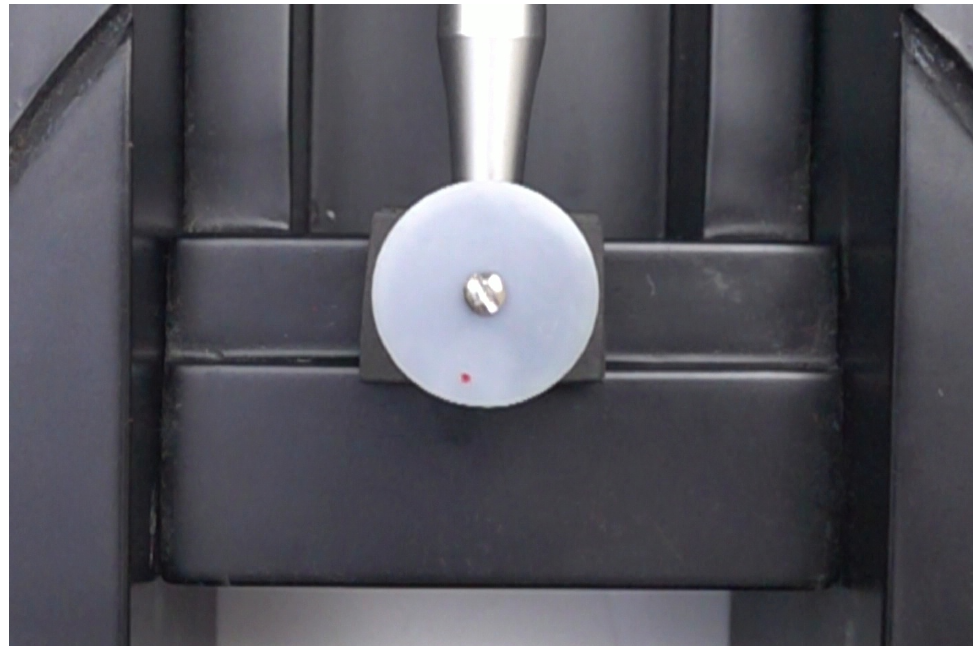
Figure 2. An example of an input image to be processed. As previously defined, each image is transformed into a grayscale image and it is cropped to comprise only information of the (white) disc. Then, after increasing visual contrast, the resulted image is processed by a Gaussian blurring filter and a threshold is defined to identify the (originally red) black dot in the image. In doing so, it is possible to identify the ( x , y ) coordinates of the red dots, which are saved into a text file. Figure